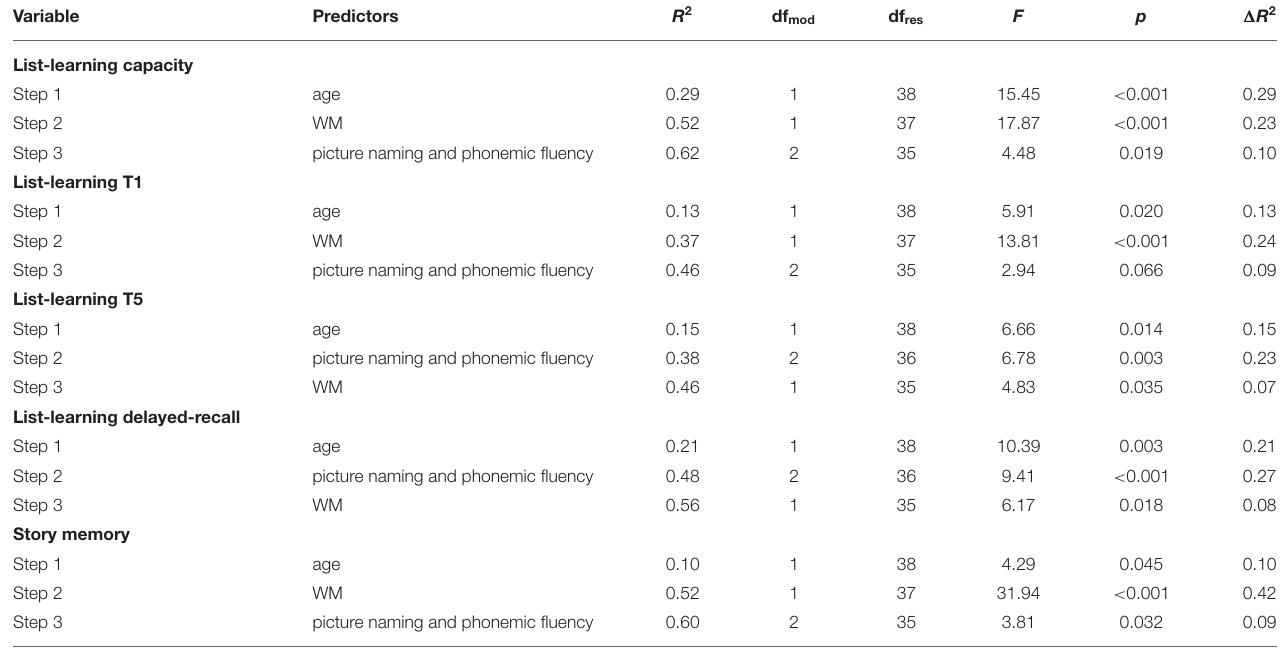
TABLE 4 | Model comparisons for variables predicting verbal learning and memory in healthy controls. Variable